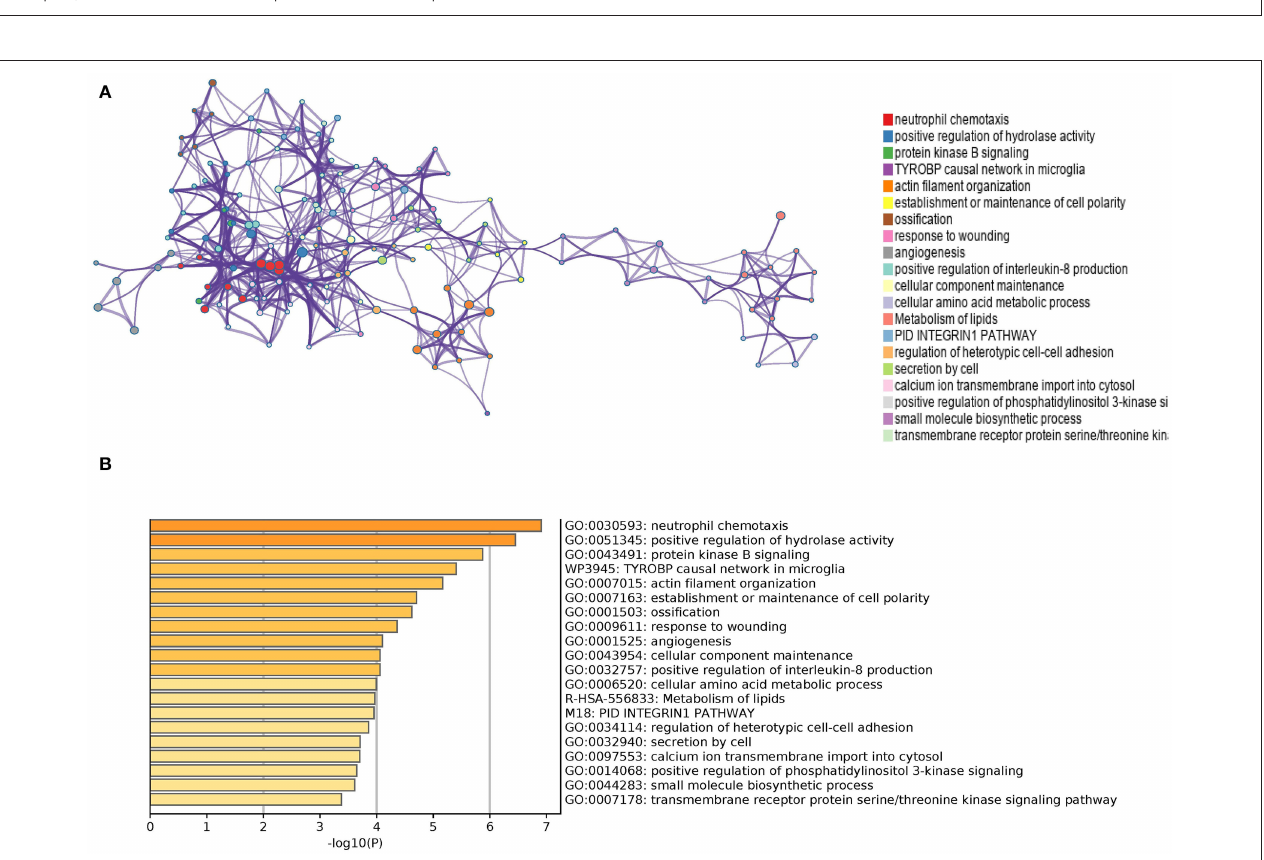
FIGURE 3 | (A) An enhanced terms network. Cluster-ID is used to color the notes, and notes with the same cluster-ID are often closer to one other. (B) P -Value-colored bar graph of enhanced phrases across DEGs lists.